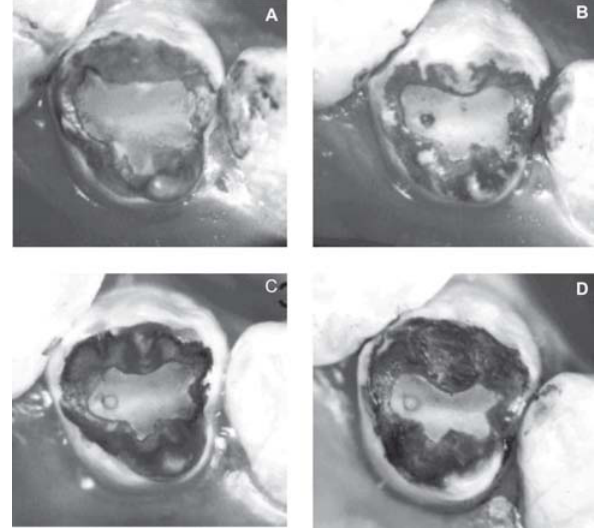
FIGURE 2- Photographs of specimen E08, left mandibular second premolar, presenting occlusal with the Concise sealant (S1), at the initial period (7 days) (T0) (A), 18 months (T1) (B), 36 months (T2) (C) and 11 years (T3) (D) after occlusal sealing